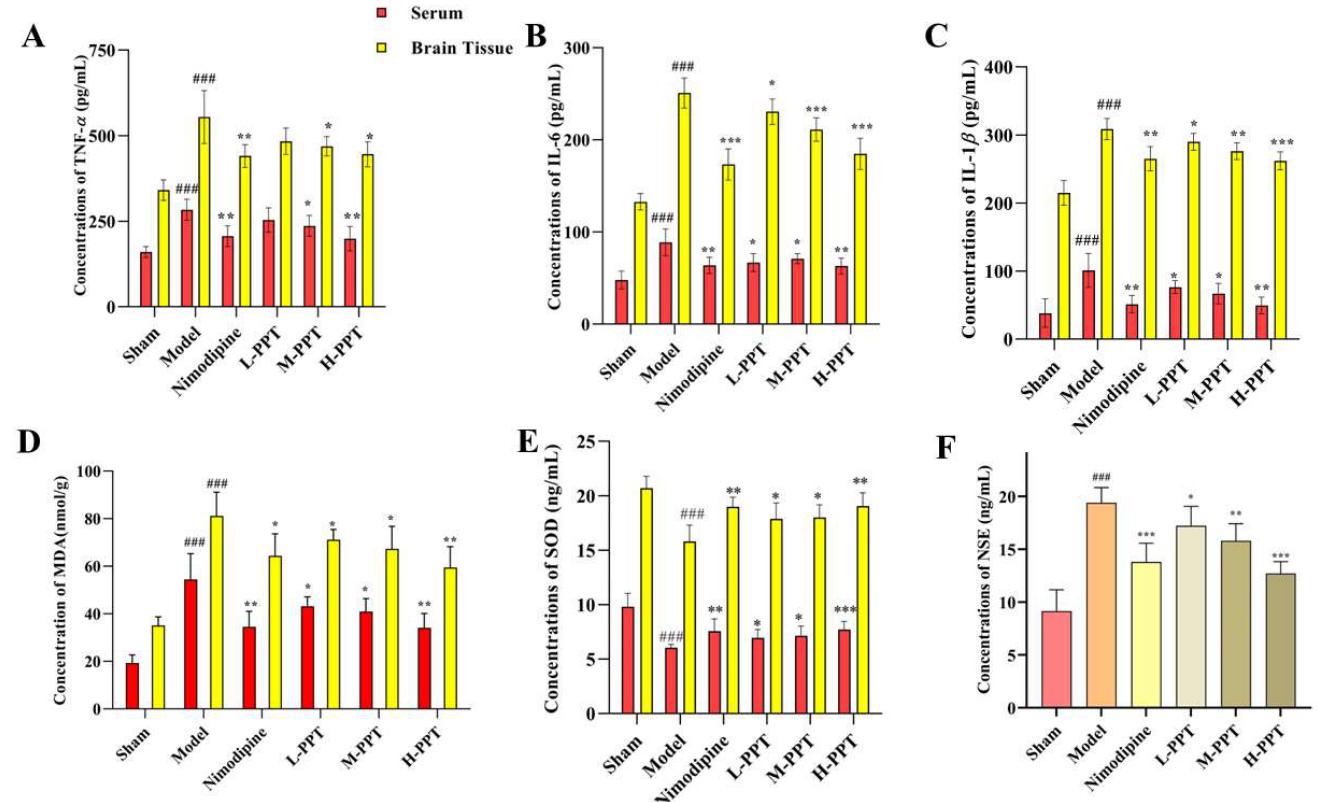
Figure 5. The result of the Elisa analysis. TNF-α, IL-6, IL-1β, MDA, and SOD of the serum and brain in the different groups ( A – E ); NSE of serum in the different groups ( F ). ### p < 0.001 vs. sham. * p < 0.05, ** p < 0.01, *** p < 0.001 vs. model